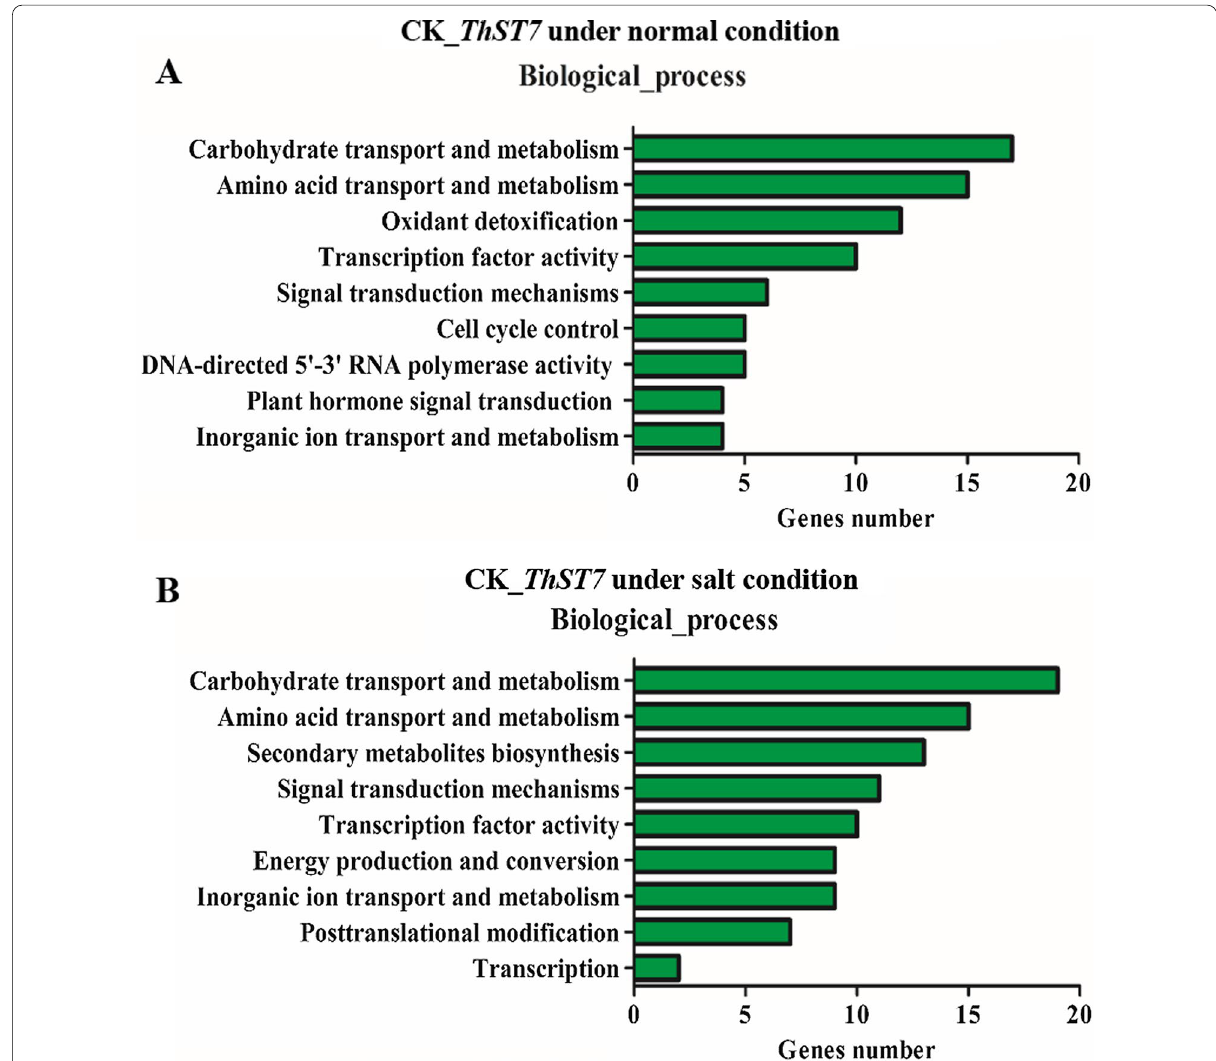
Fig. 6 The Gene ontology(GO) grouped up-regulated genes in different biological processes. A The number of genes involved in the biological processes under normal conditions. B The number of genes involved in the biological processes under salt